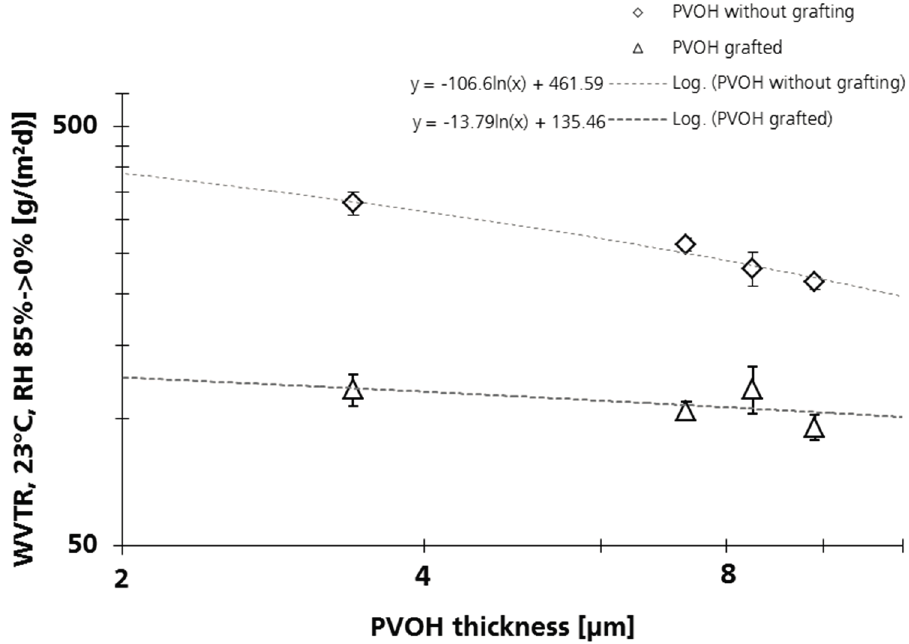
Figure 5. WVTR of different PVOH (28-99) thicknesses coated on MET (paper for metalizing) paper with and without C16